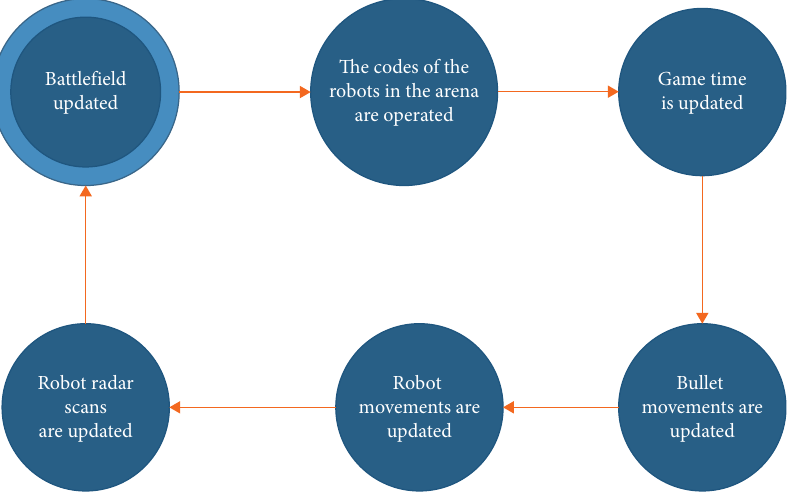
Figure 2: The flow diagram of the process cycle used by the RoboCode engine.